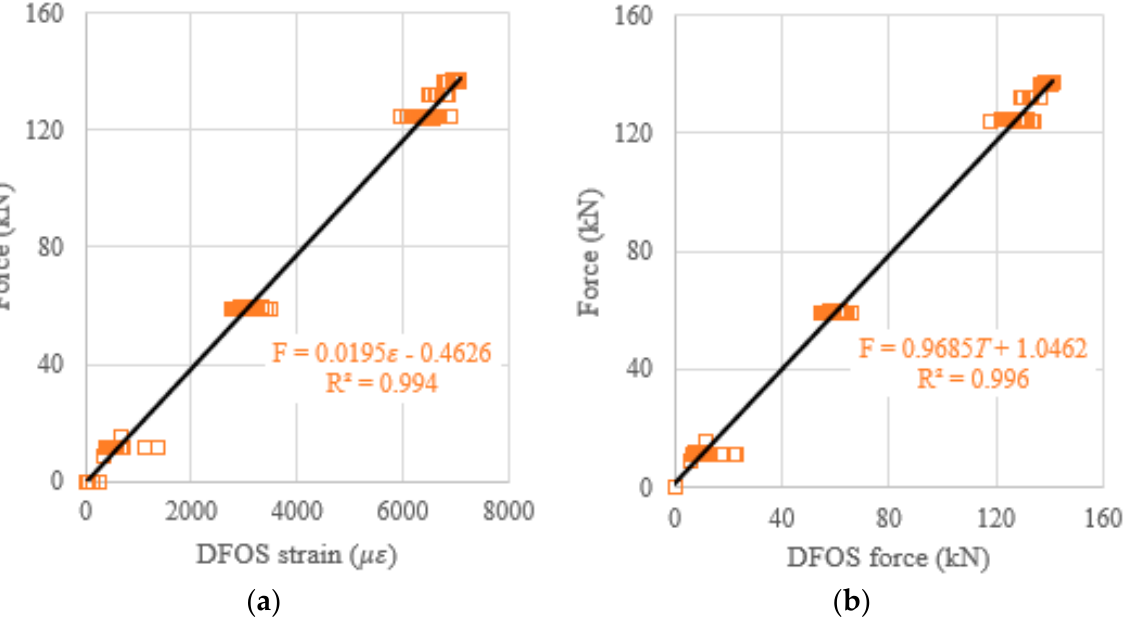
Figure 16. ( a ) Prestressing force versus DFOS-max. strain; and ( b ) prestressing force versus DFOS max. strain-calculated force.